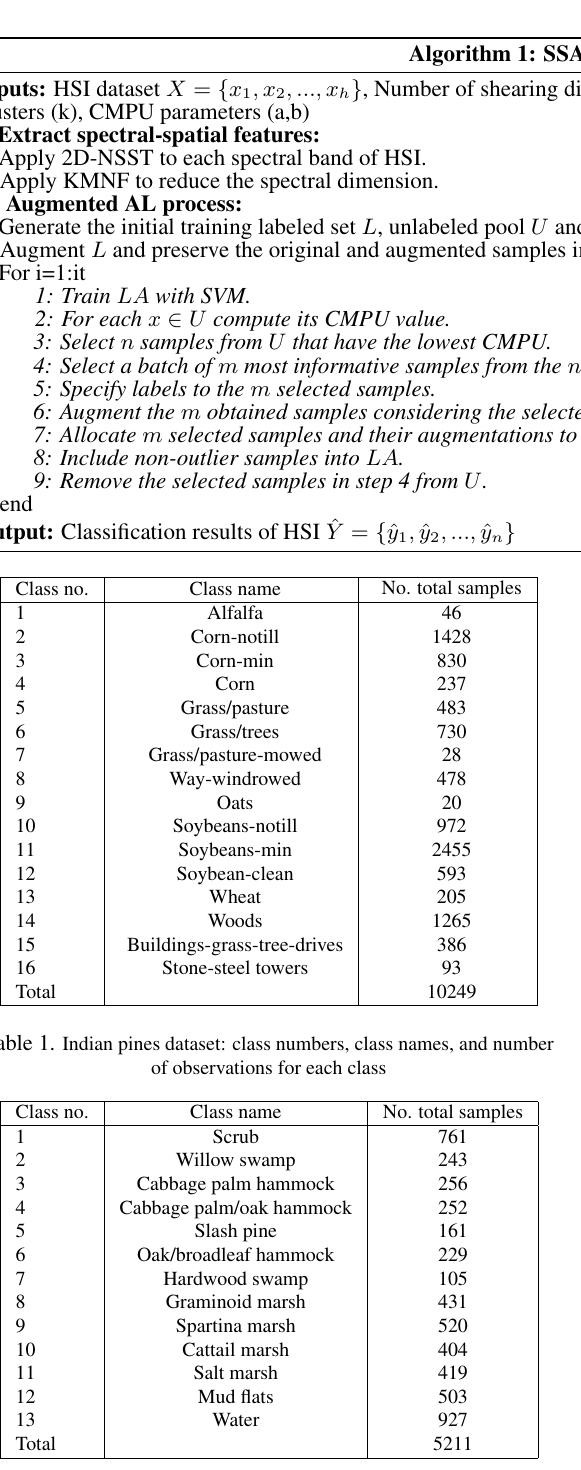
Table 2. KSC dataset: class numbers, class names, and number of observations for each class